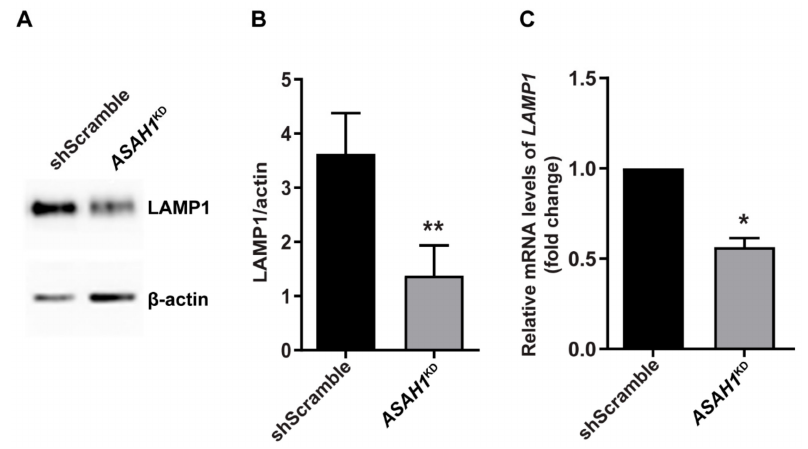
Figure 6. Decrease of protein and mRNA levels of LAMP1 in ASAH1 KD cells. ( A ) Representative immunoblot using antibodies against LAMP1 and β -actin. ( B ) Levels of LAMP1 normalized for β -actin expression. Data are expressed as mean ± SD ( n = 4, ** p < 0.003, Student t -test). ( C ) Relative mRNA expression levels of LAMP1 in ASAH1 KD cells to shScramble cells after normalization with GAPDH. Data are represented as the mean ± SEM of two independent triplicate experiments (* p = 0.02, Student t